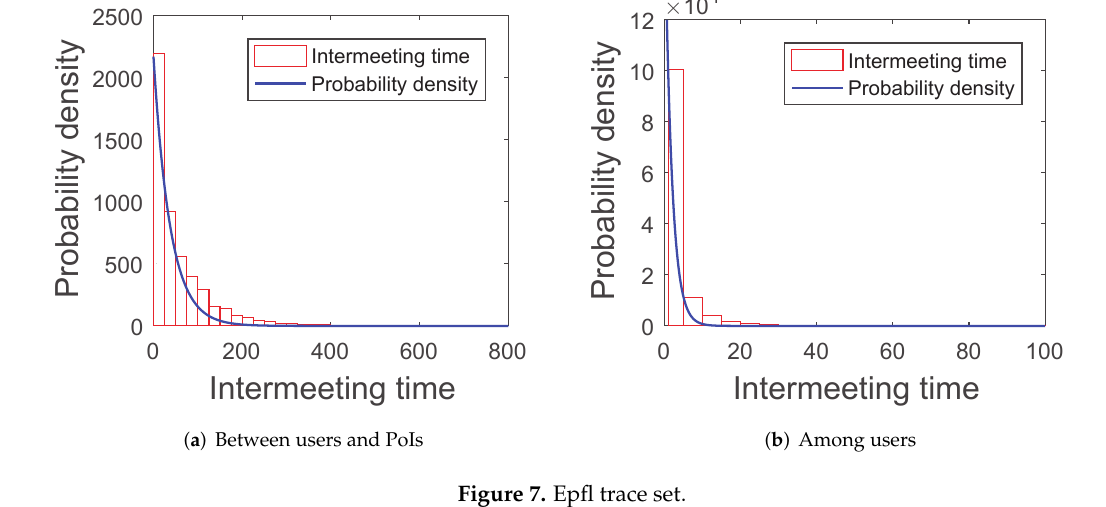
Figure 6. Roma/taxi trace set.